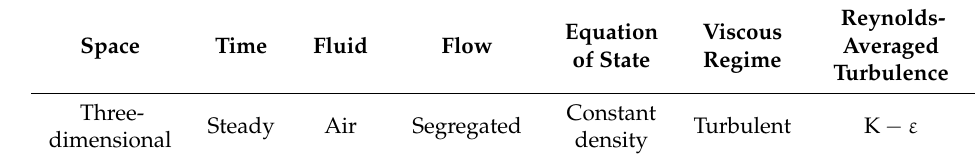
Figure 4. Schematic diagram of the simulation model. Table 2. Physical conditions.